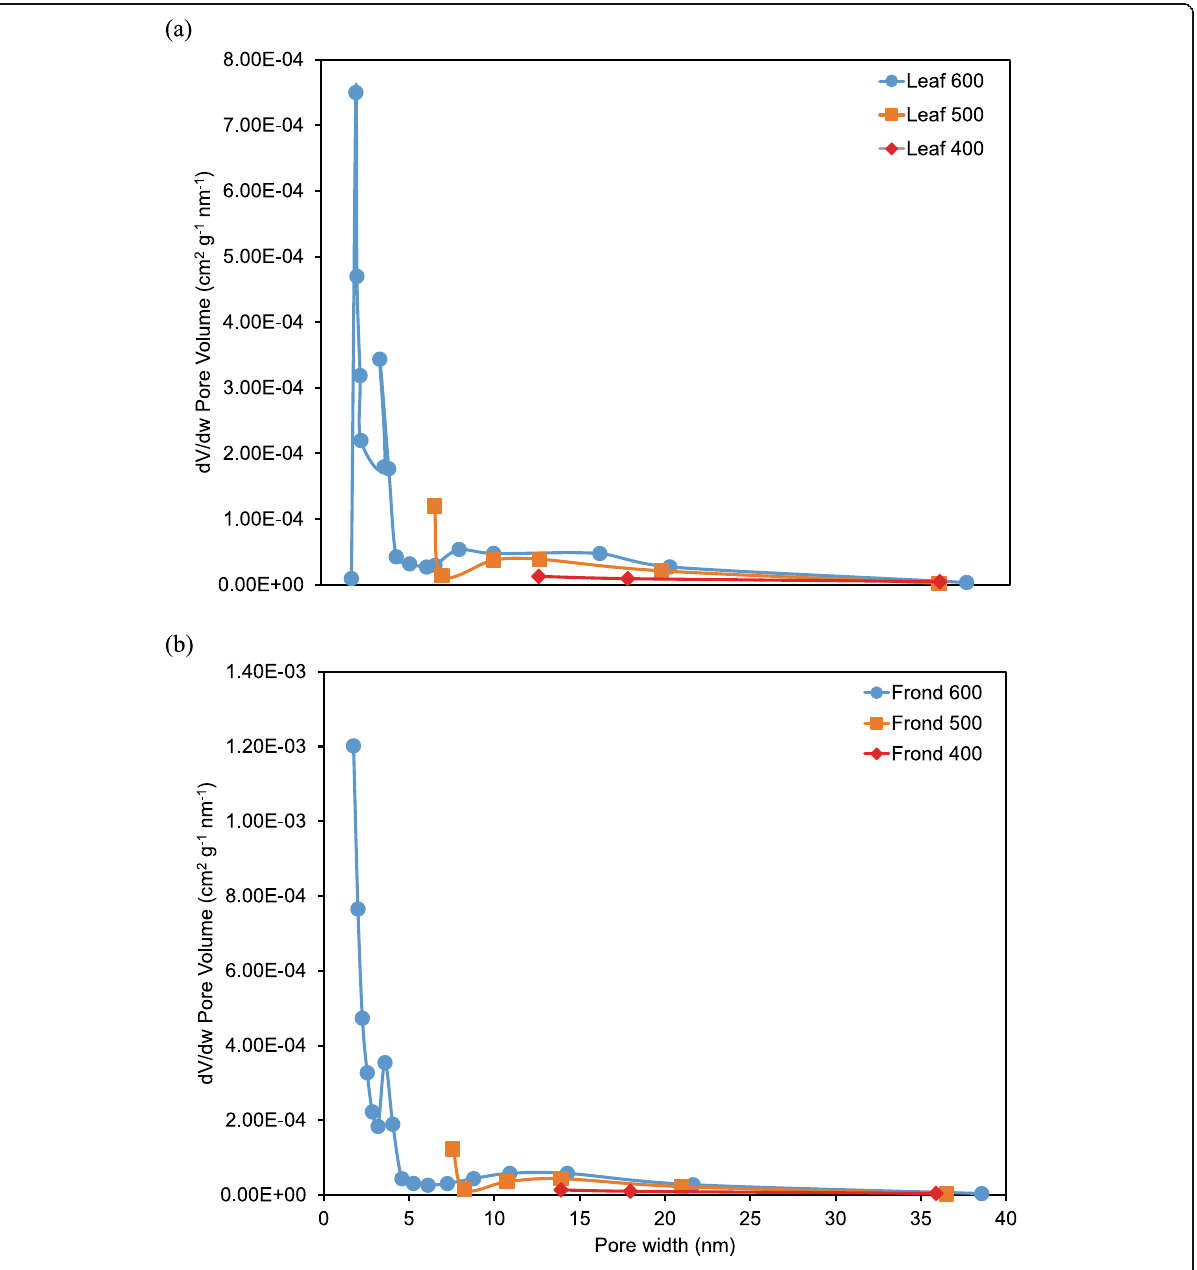
Fig. 5 Pore size distribution at various pyrolysis temperatures of a leaf biochar b frond